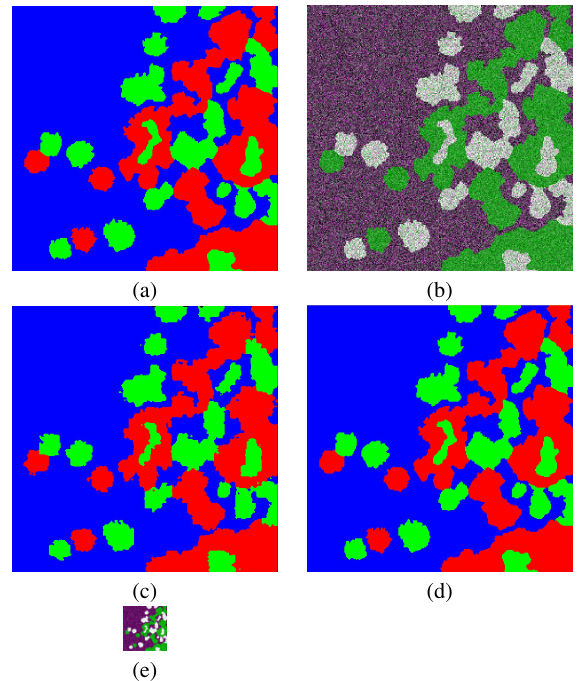
Figure 5: (a) Reference map of simulated dataset. (b) Simulated image with 2 bands and scale factor 1. (c) Adaptive MRF-SPM result. (d) Improved adaptive MRF-SRM result. (e) The real proportional size of degraded simulated image with scale factor 6 (produced from Figure 5(b)) which is used to generate SR maps presented in Figures 5(c & d))